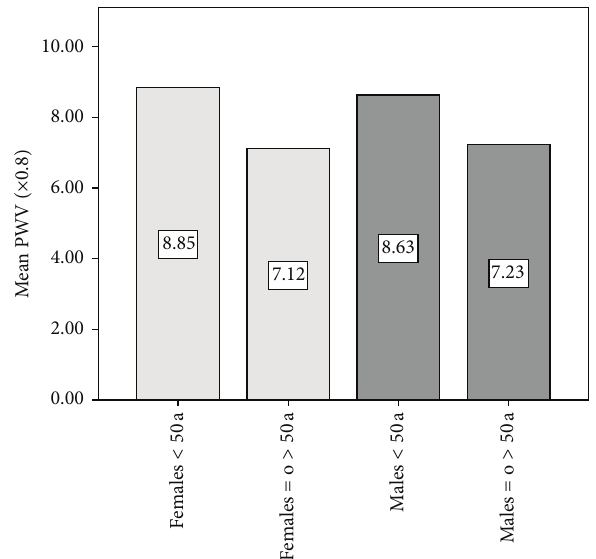
Figure 3: Mean values of pulse wave velocity (PWV: in meters per second) showing significant differences between young subjects ( ≤ 50 years) and subjects > 50 years included in the study. There were no significant differences of PWV in relation to gender for the same age